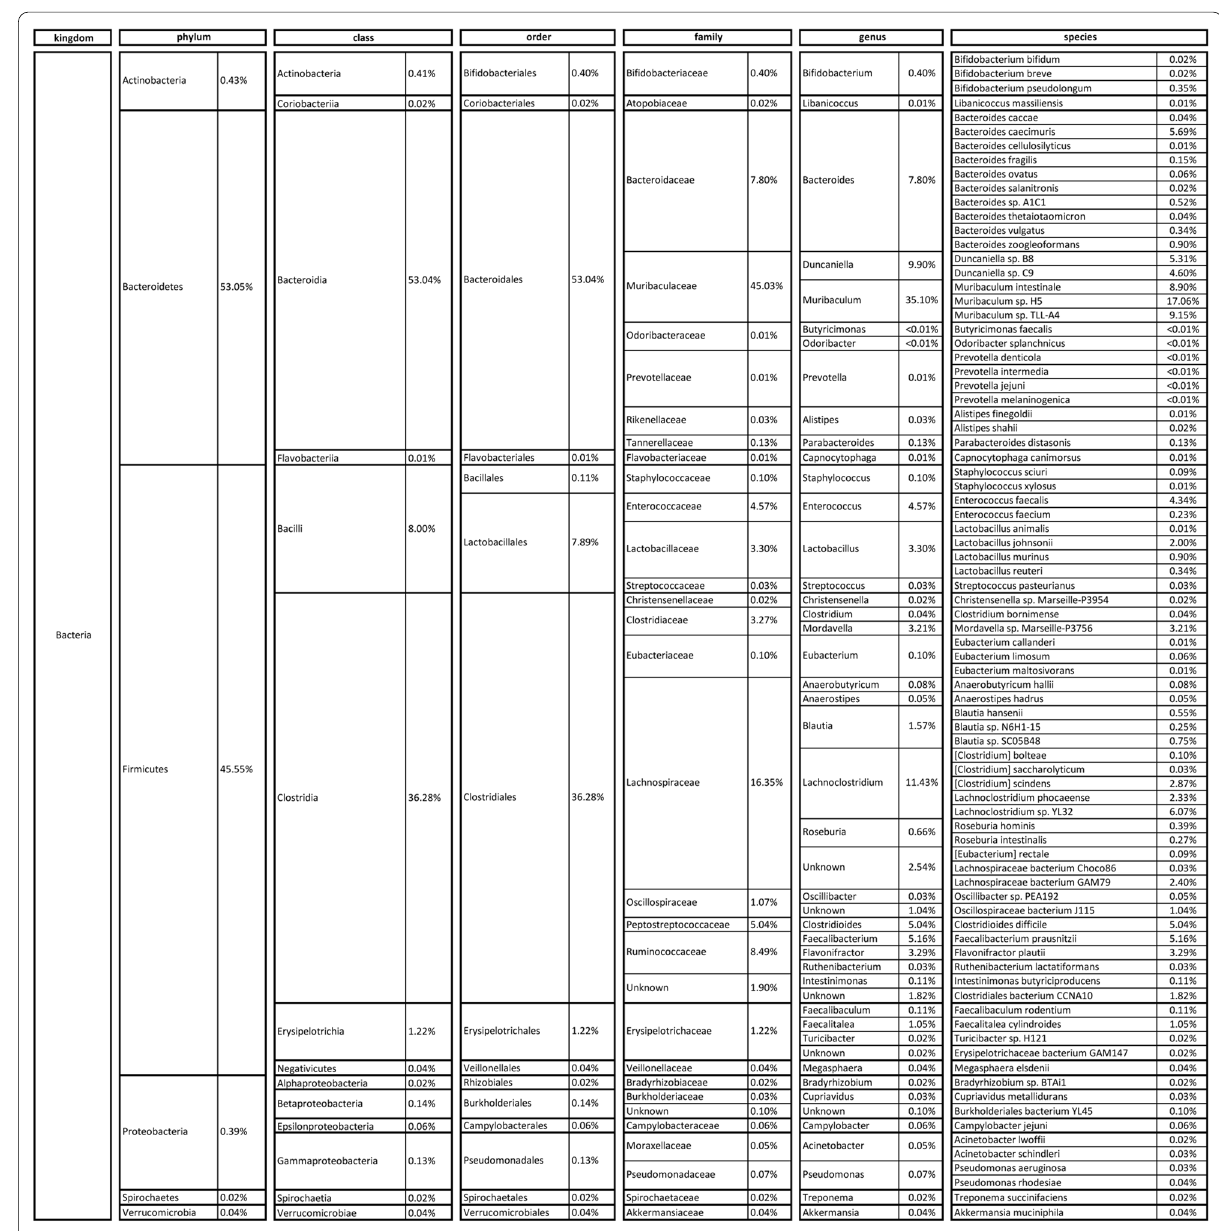
Fig. 2 Bacteria composition of SPF samples. Taxonomy of gut bacterial microbiota of SPF samples reveals that 82 species represent more than 99% of the intestinal microbiota, belonging to 31 families, the most abundant being Muribaculaceae (45.03%), Lachnospiraceae (16.35%), Ruminococcaceae (8.49%), and Bacteroidaceae (7.8%). Bacterial composition at phylum, class, order, and genus level is also